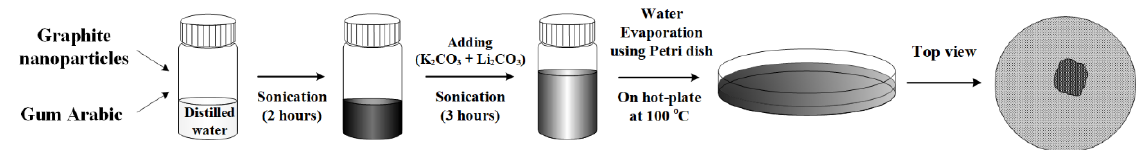
Figure 2. Synthesis procedures for molten salt nanofluids.